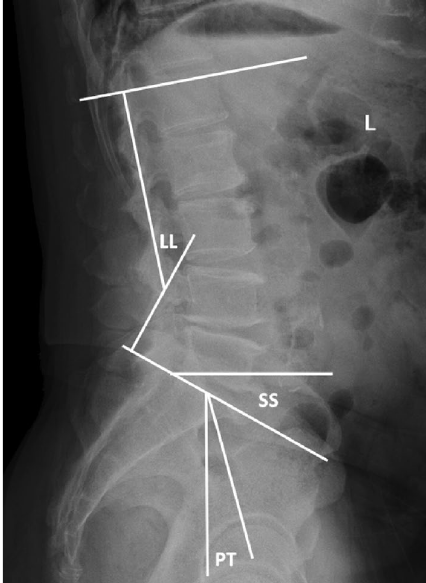
Figure 1. LL is defined as the angle between the end plate on L1 and the continuous end plate on S1.PT is defined as the angle between the connection and plumb line at the midpoint of the end plate and the center point of the femoral head on S1.SS is defined as the angle between the parallel and horizontal lines of the end plate on